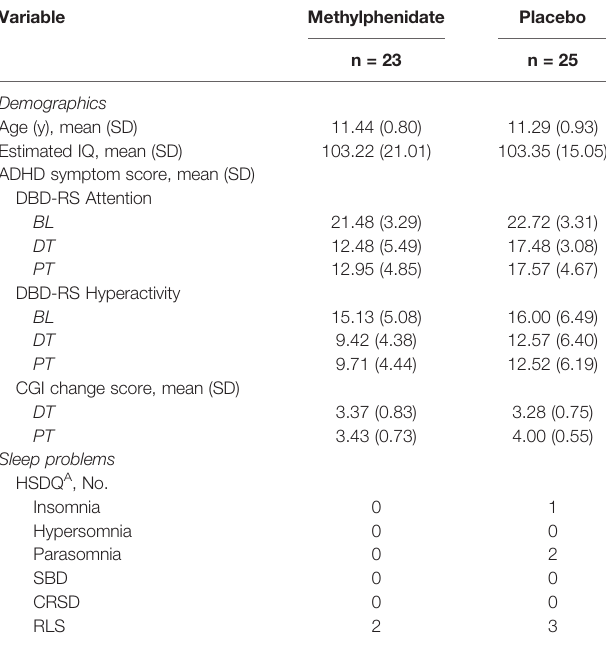
TABLE 2 | Baseline demographics and clinical characteristics of the study subjects. Variable